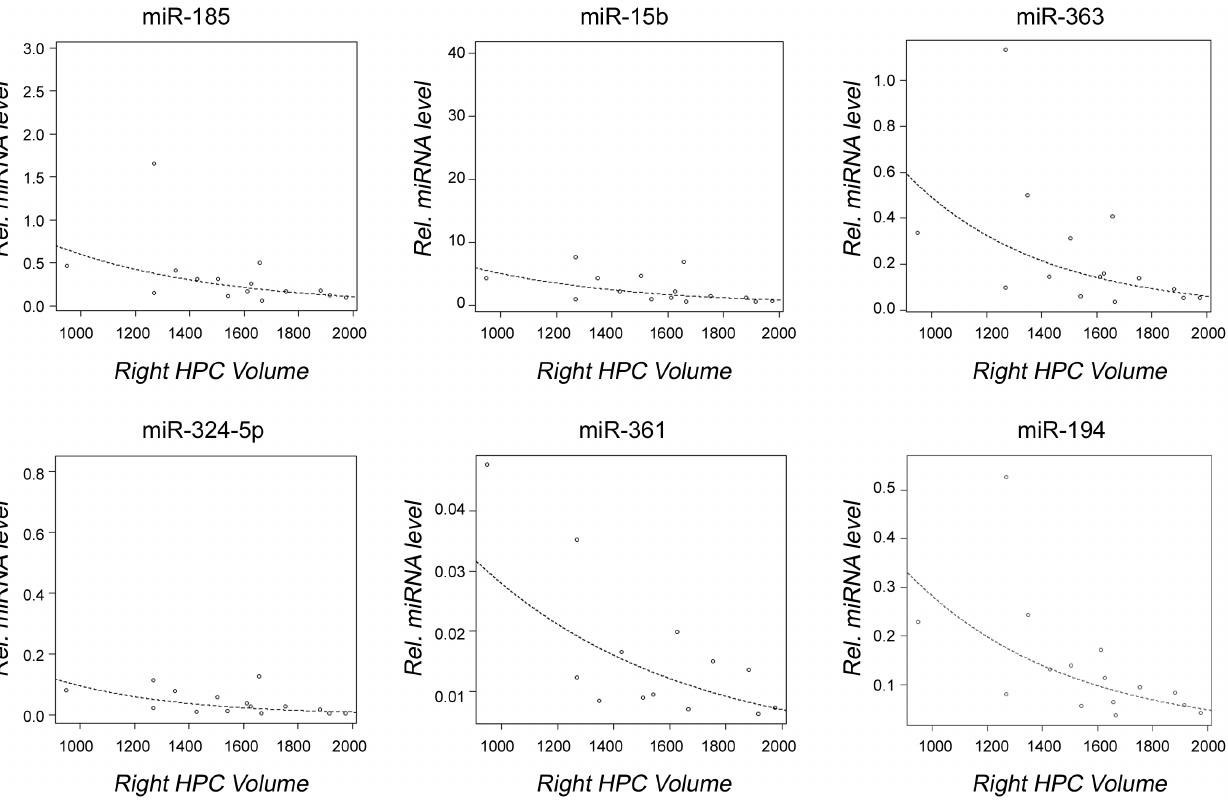
Figure 6. Observed correlation between dysregulated miRNAs and right hippocampal volume. Graphs showing a significant correlation between miRNA expression levels and right hippocampal volume within the individuals with 22q11DS are shown. Open circles represent individuals with 22q11DS; the line represents line of best fit. P-values given are for each miRNA.